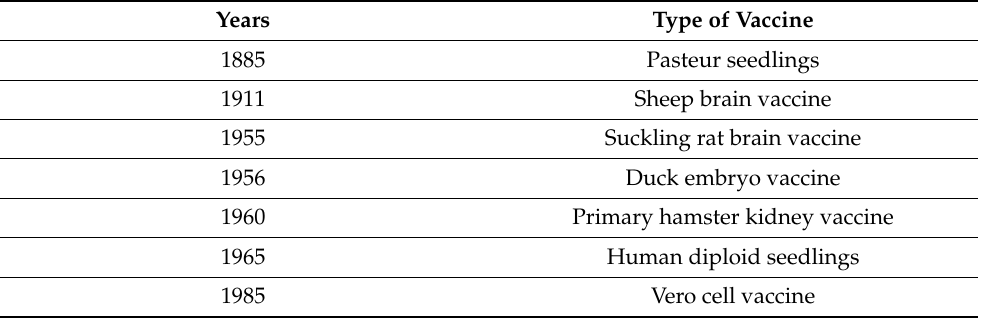
Table 2. Development of RABV